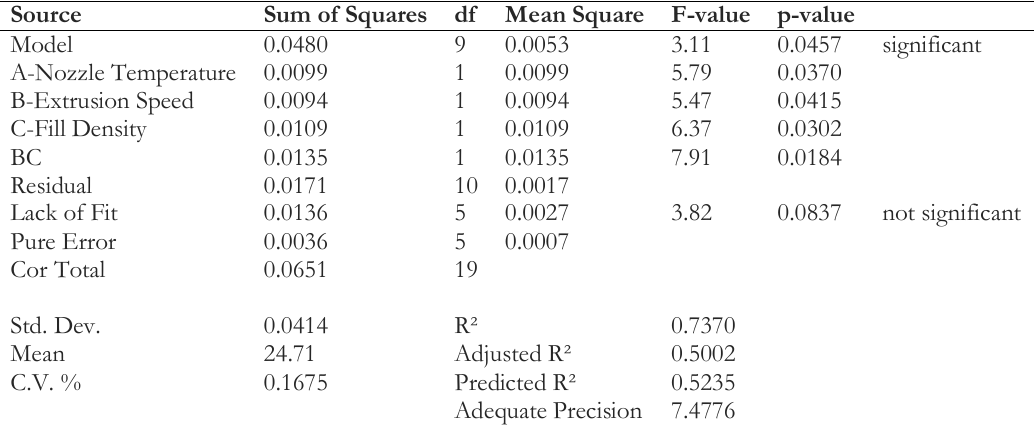
Table 4. ANOVA for main and interaction effects on average gear bore